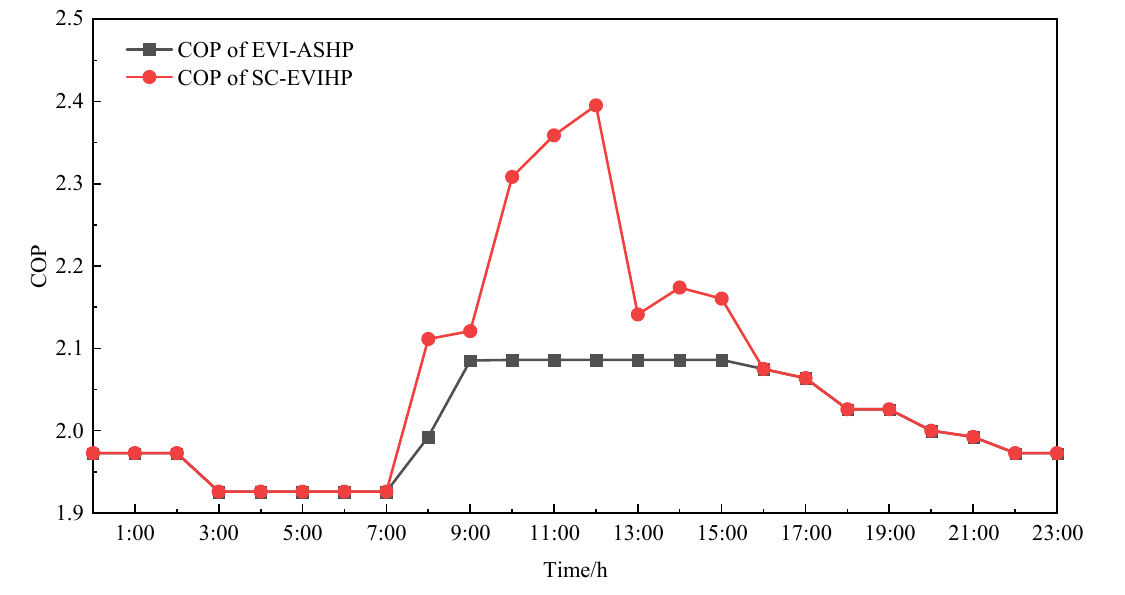
Figure 8. Comparison of COP of the systems.